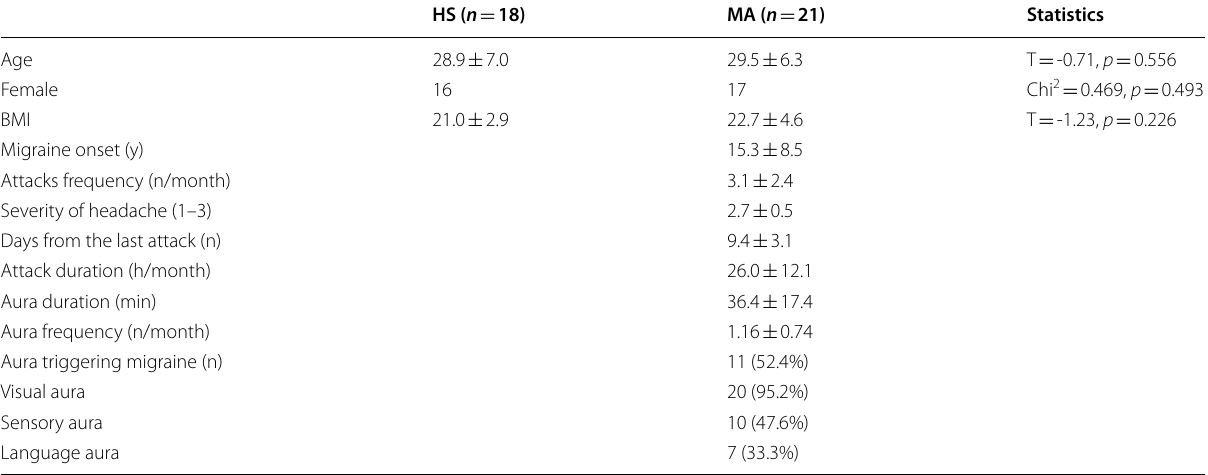
Table 1 Demographic and clinical features of study’s participants. Inferential statistics based on Student’s t -test and Chi-square method